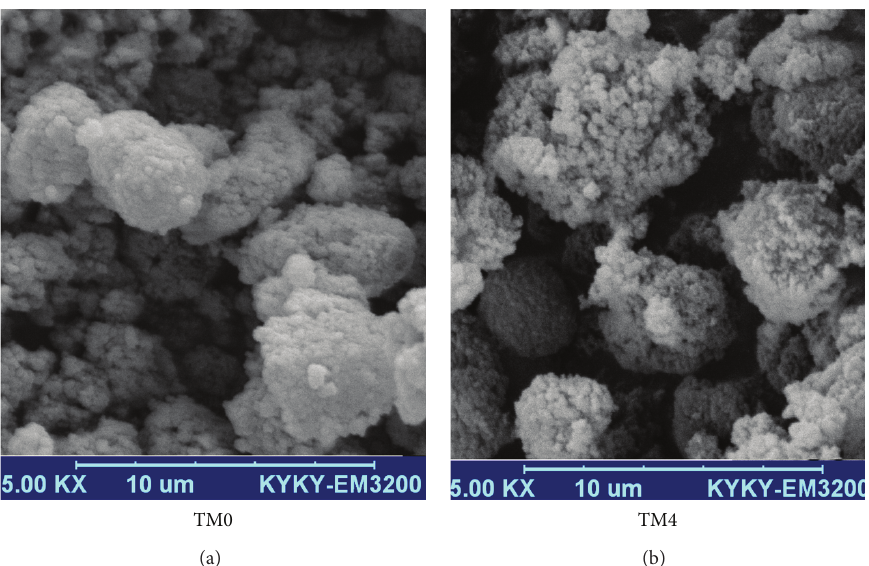
Figure 7: SEM images of toner synthesize with various types of Fe 3 O 4 particles.